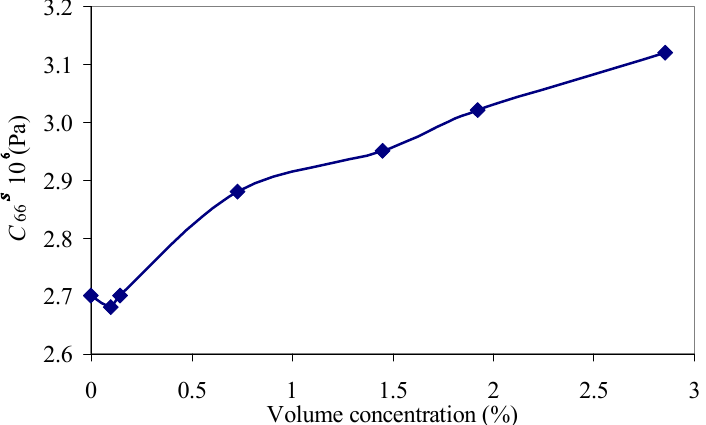
Figure 9. The dependence of the shear modulus of the elasticity C66s of the suspension on the volume concentration of diamond particles with particle sizes of 1–2 µm.